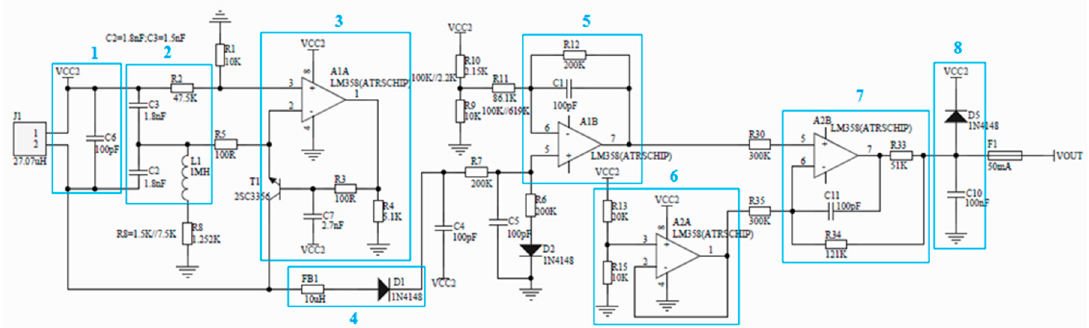
Figure 10. Parameters of the design sensor.